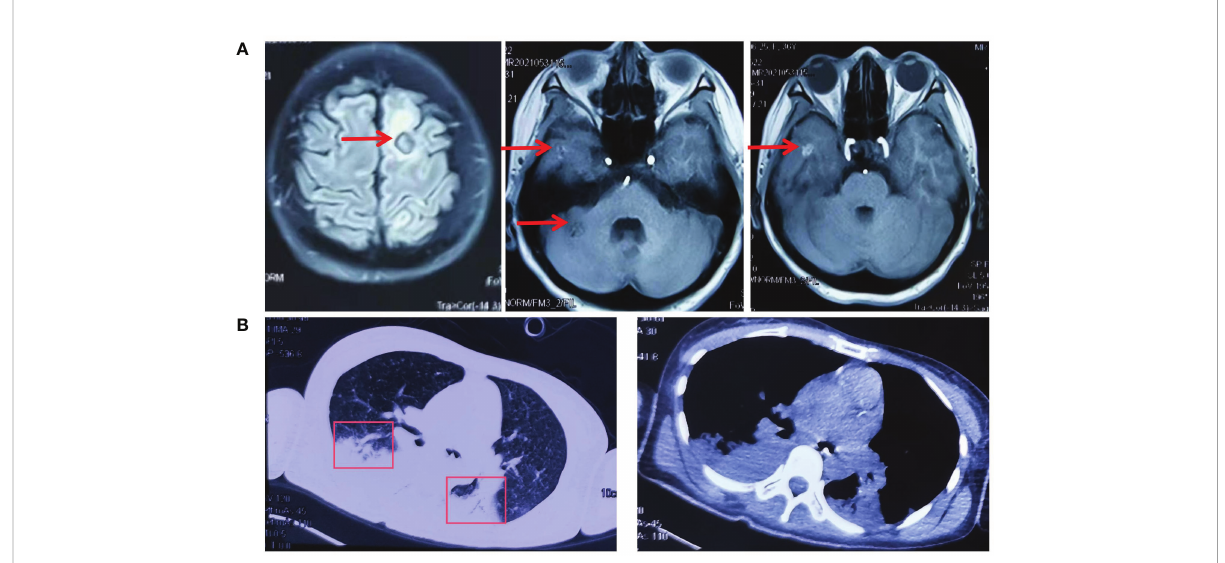
FIGURE 2 The cranial MR and CT of the chest before and after lazertinib and amivantamab treatment. (A) In May 2021, cranial MR showed multiple abnormal signals in the left frontoparietal-occipital lobe, basal ganglia region, thalamus, and right cerebellar hemisphere; (B) In July 2021, CT of the chest showed pulmonary atelectasis and pleural